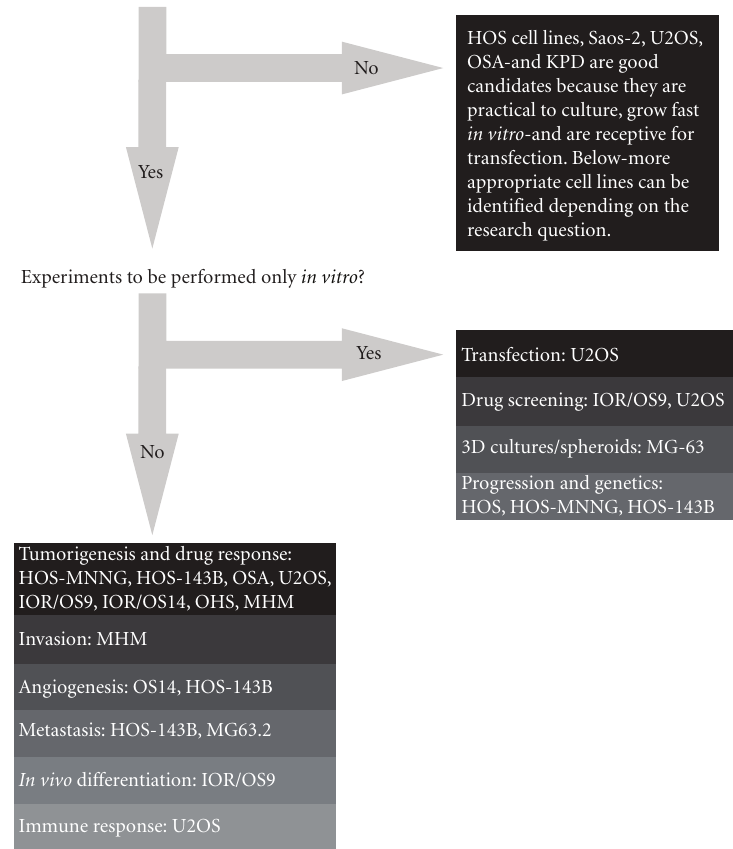
Figure 4: Human osteosarcoma cell lines : which cell line to use? The flow diagram suggests appropriate cell lines to use for certain research question. Decision-making for this diagram is based on reported genetic, phenotypical and functional analyses of these cell lines, and lab experience from unrelated experiments by the authors and direct collaborators.